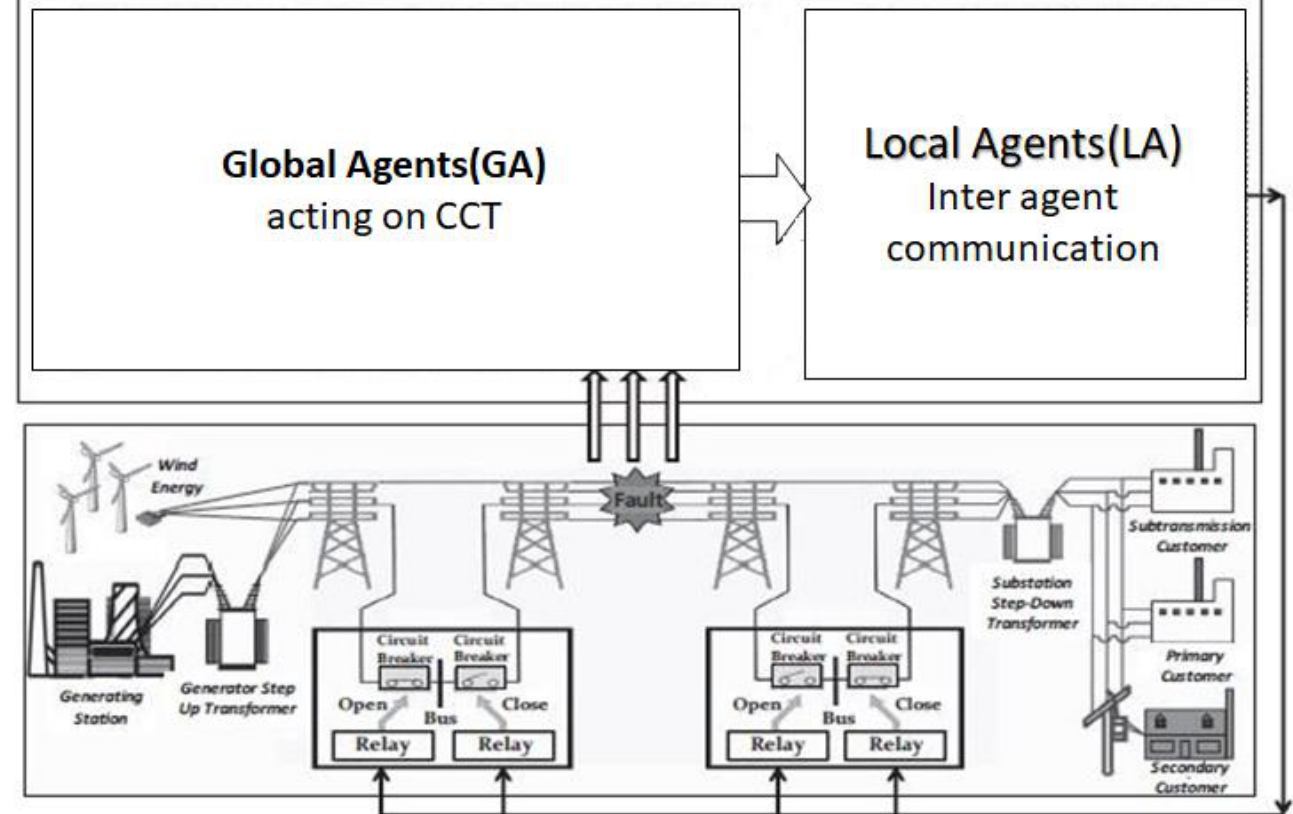
Figure 4. Flowchart of SSG interaction with the multi-agent system in case of fault [25].